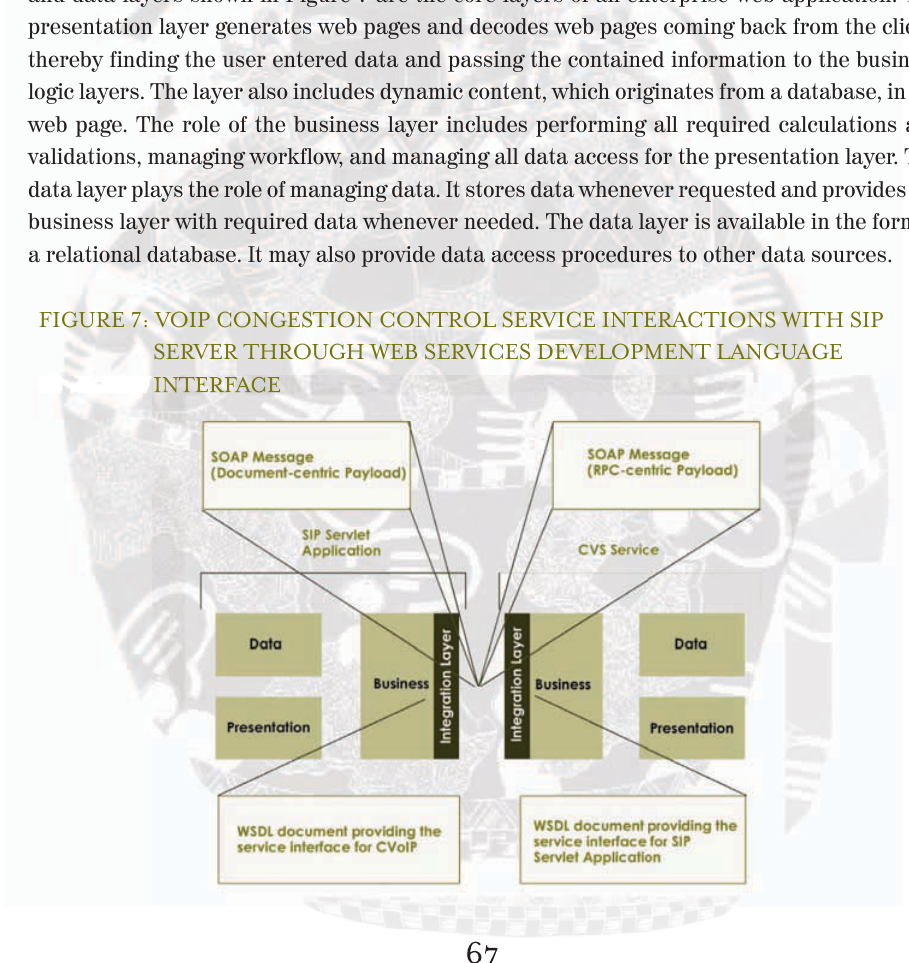
Figure 7 highlights how WSDL interfaces VCS and the SIP server. The presentation, business,